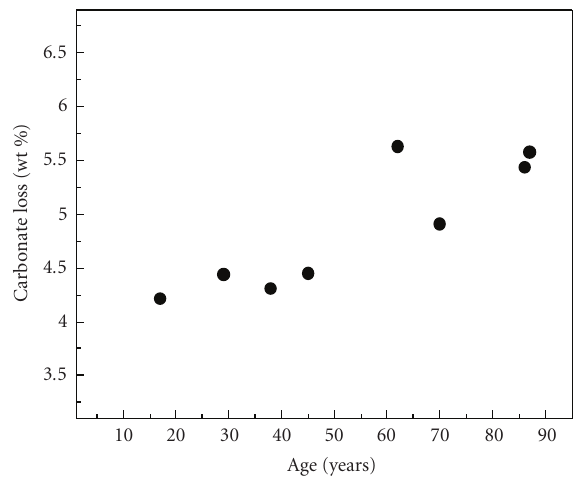
Figure 5: The c-lattice constant as a function of age.